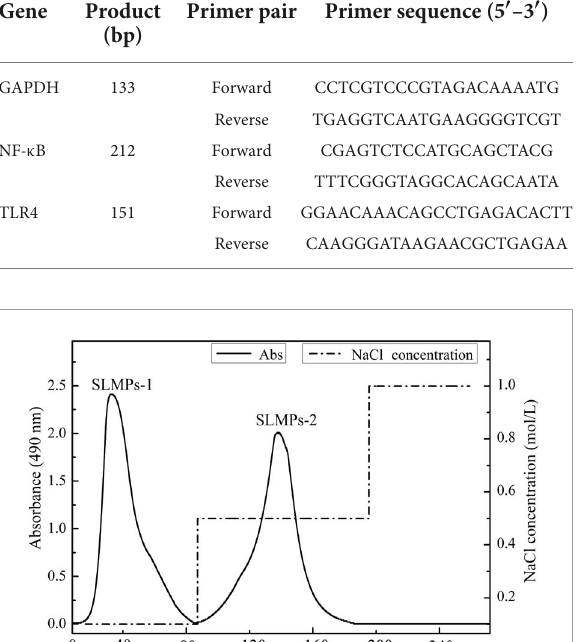
FIGURE1 Elution profile of SLMPs by anion exchange chromatography on a DEAE-52 cellulose column.